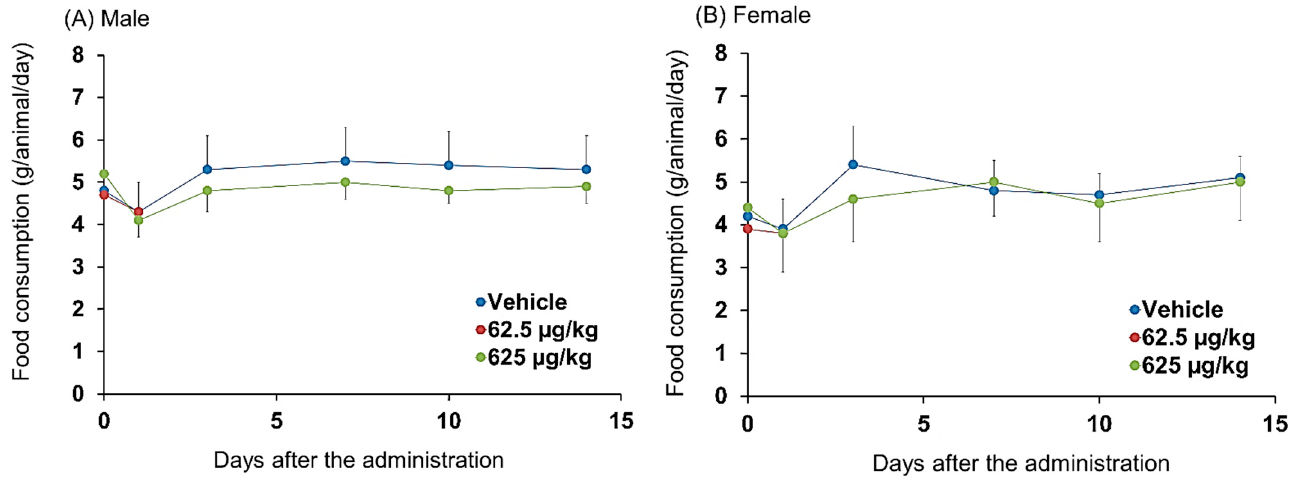
Figure 5. Changes in food consumption of mice after the intraperitoneal administration of Cu- NCAB001. ( A ) Male. ( B ) Female. Plots of average food consumption for each treatment group in the extended single-dose toxicity study are shown. Values are presented as mean ± SD. The means were calculated based on the following number of values: days 0 and 1, vehicle and 625 µ g/kg groups, n = 15; 62.5 µ g/kg group, n = 10; day 3 and thereafter, vehicle and 625 µ g/kg groups, n = 5. As there were no significant differences in histopathological observations between the 625 µ g/kg-treated and control groups on day 1, the 62.5 µ g/kg-treated group was not subjected to assessment of food consumption from day 2 to day 14. No statistically significant changes were observed.